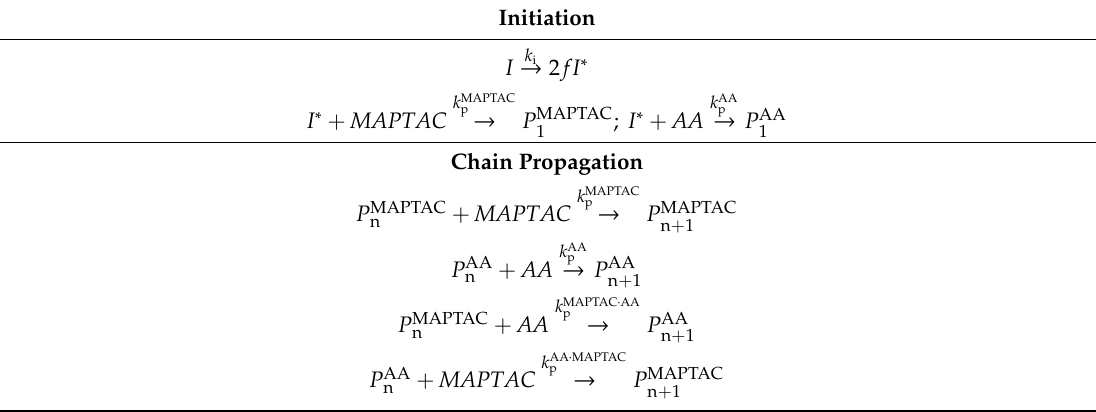
Table 1. Reaction steps included in the AA-MAPTAC copolymerization